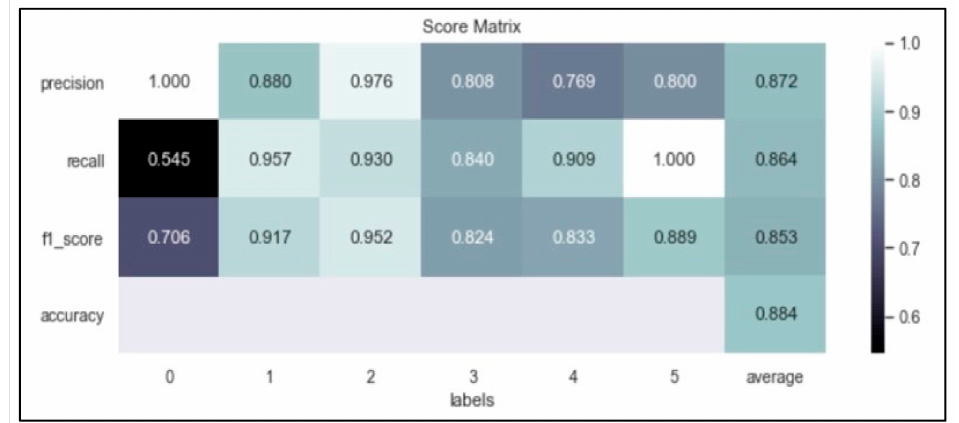
Figure 24. Confusion-matrix evaluation